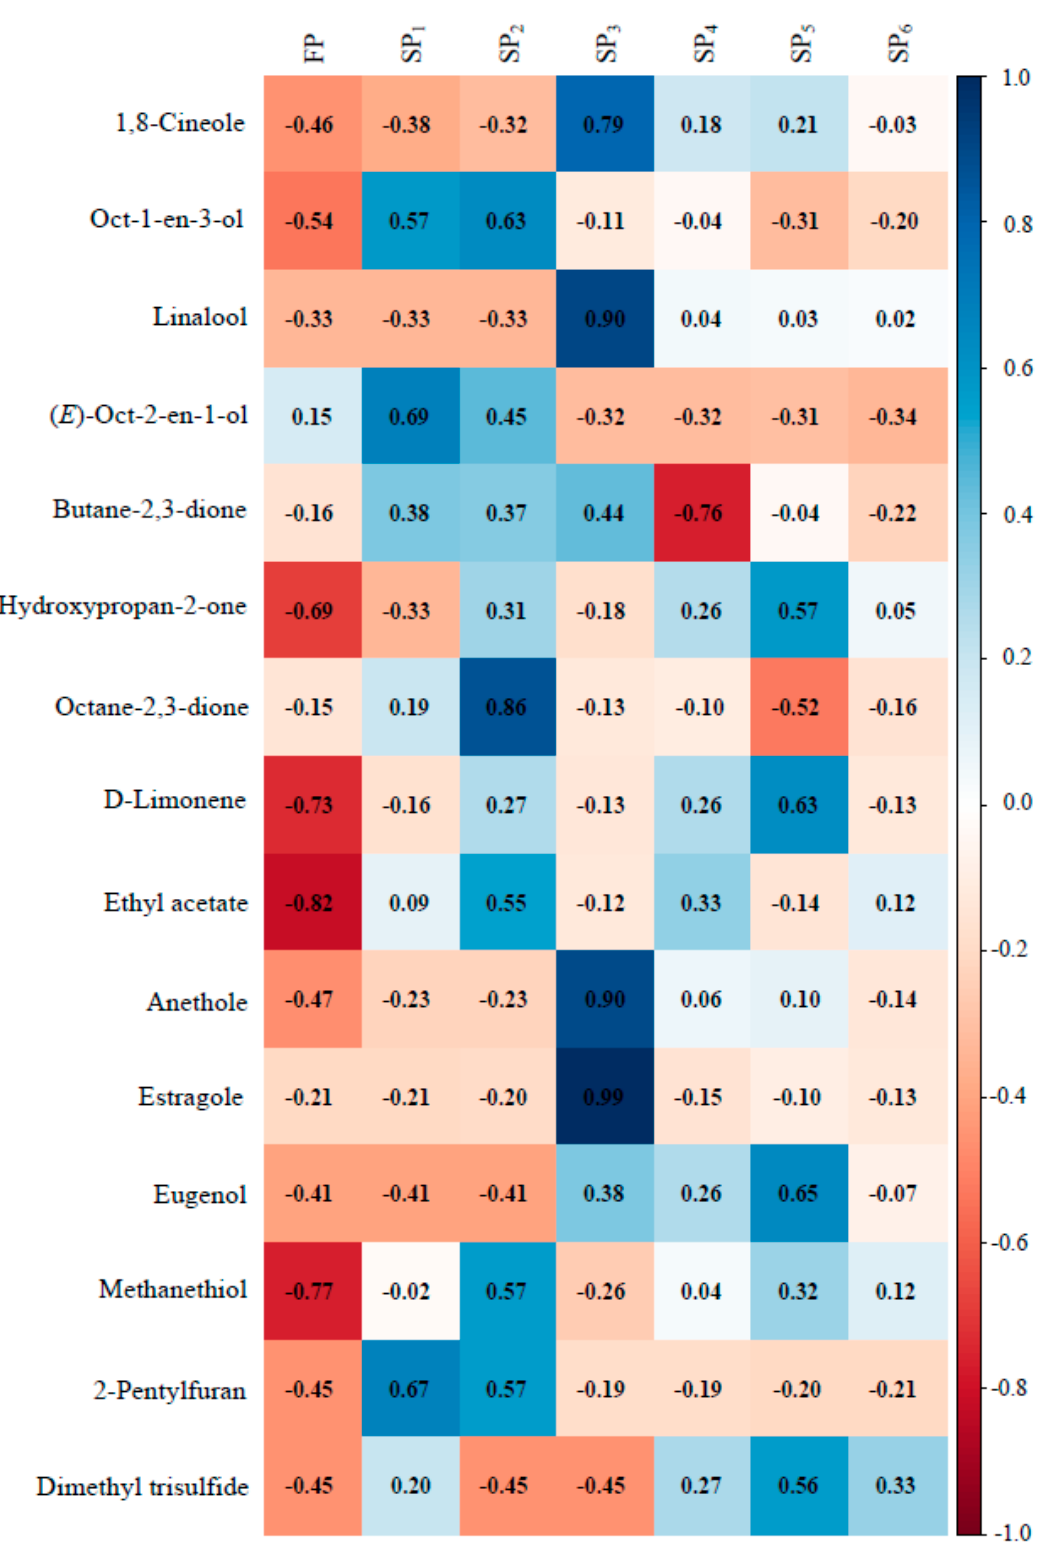
Figure 3. ( a ) Loading biplot of t1 and t2 of the model performed after PLS-DA of the volatile compounds in different pork samples (R 2 X = 0.968, R 2 Y = 0.818 and Q 2 = 0.628). ( b ) Heat map of the correlations between volatile compounds and the pork samples. FP, fresh pork; SP 1 , stewed pork with water; SP 2 : stewed pork with water and salt; SP 3 : stewed pork with water, salt and spices; SP 4 : stewed pork with water, salt, spices and soy sauce; SP 5 : stewed pork with water, salt, spices, soy sauce and sugar; SP 6 : stewed pork with water, salt, spices, soy sauce, sugar and cooking wine. The blue circle dots represent the fresh and stewed pork and the red triangle dots represent the odour-active